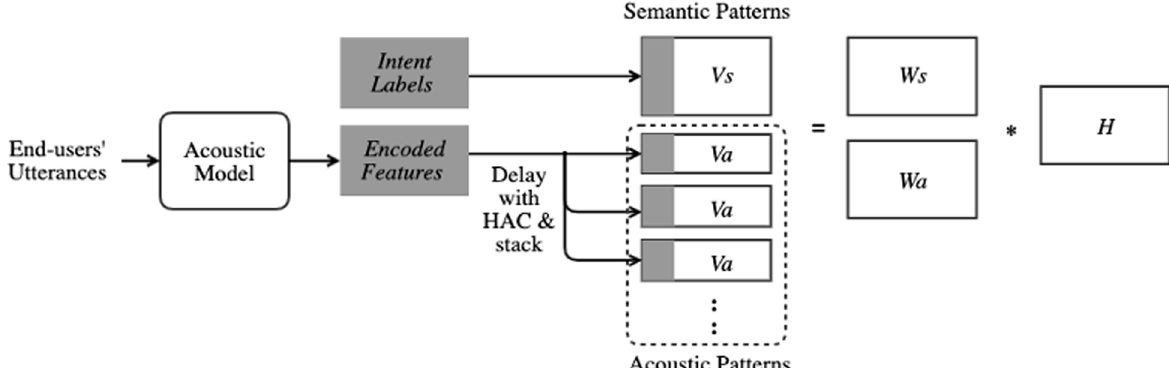
Fig. 6 The structure of the NMF-based intent